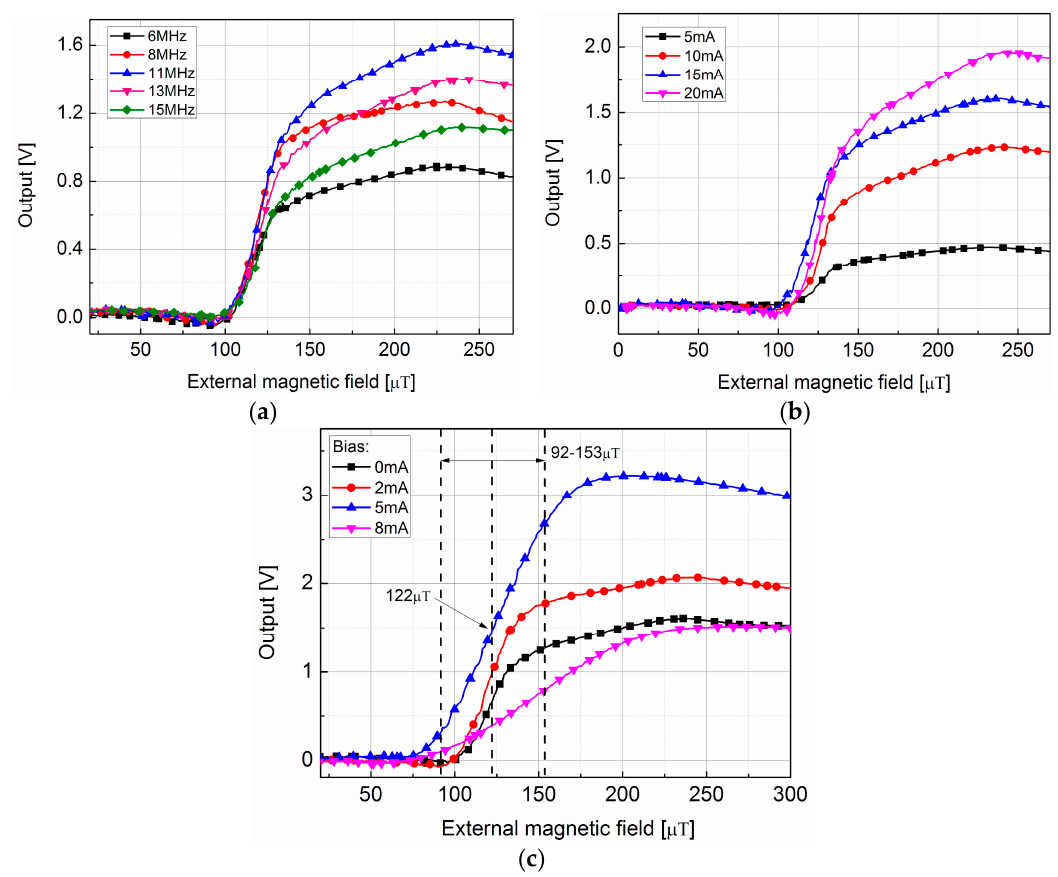
Figure 9. Sensor output voltages versus the external magnetic field characteristics. The results show comparisons between excitations with ( a ) different frequencies; ( b ) different amplitudes; ( c ) different DC bias.